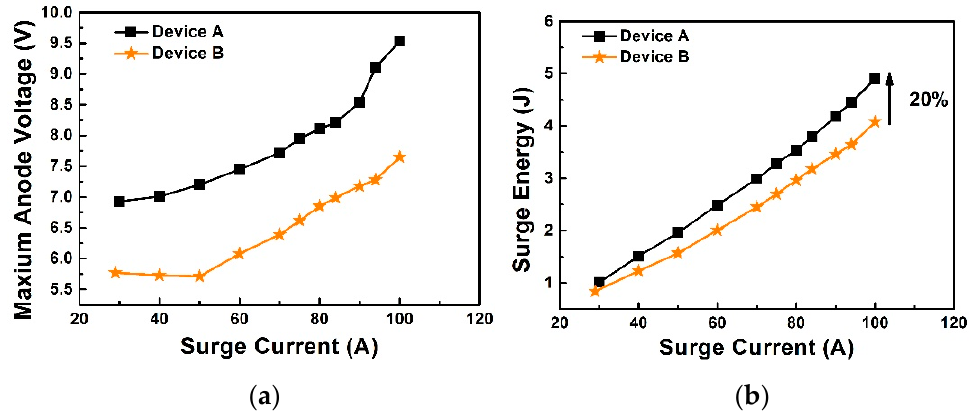
Figure 14. ( a ) Summary of maximum voltage at different surge currents for Device A and Device B. ( b ) Summary of dissipated energy at different surge currents for Device A and Device B.